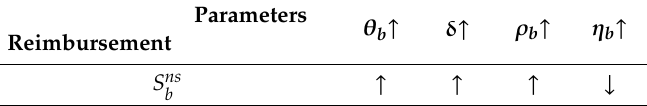
Table 3. Relationship between subordinate hospital insurance reimbursement and